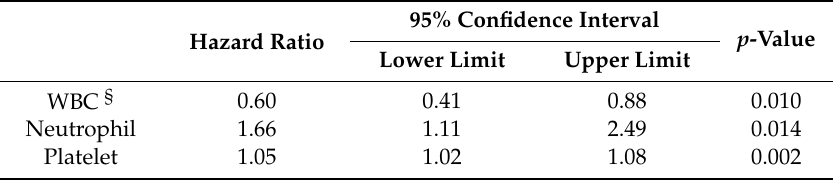
Table 3. Results of multivariate analysis to predict hematogenous recurrence.